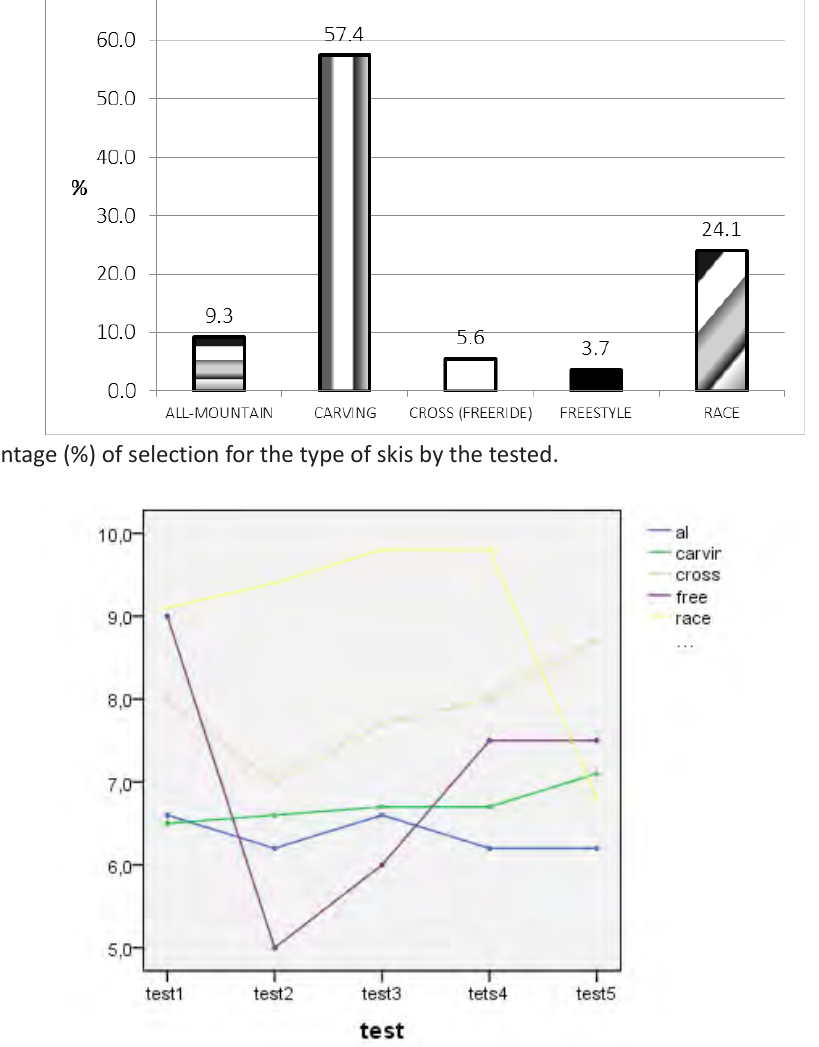
Figure 2. Resulting score of 5 tests - criteria in relation to the type of